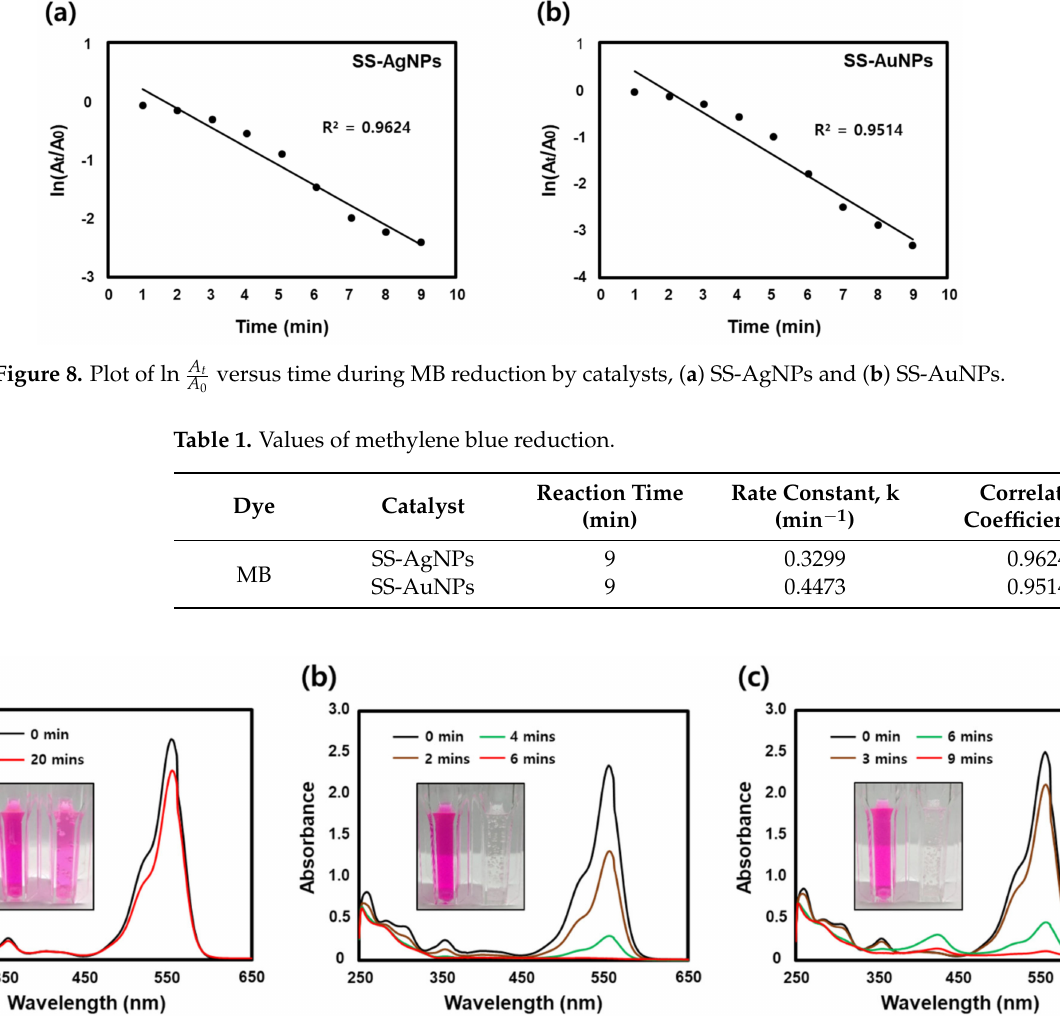
Figure 9. UV–Vis spectra of rhodamine B (RB) dye reduction in the presence of different catalysts, ( a ) NaBH 4 , ( b ) SS-AgNPs, and ( c ) SS-AuNPs.